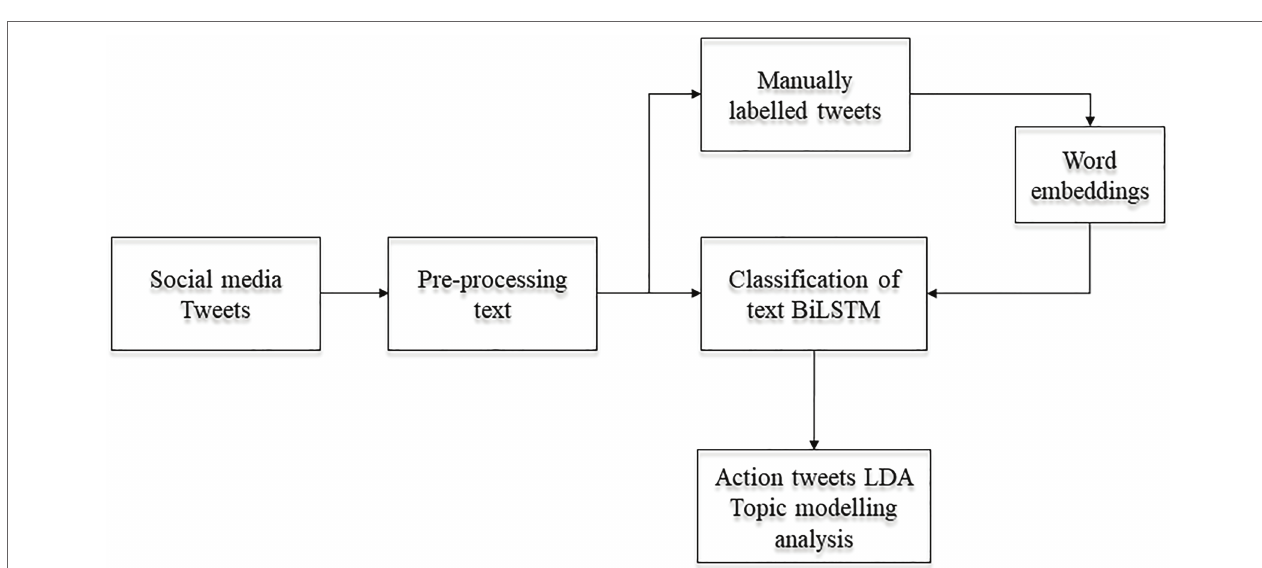
FIGURE 1 | Diagram of tweets processing and analysis. Tweets were streamed from social media on the three-timepoints, then pass through a pre-processing phase (removal of punctuation, mentions, etc.). A Bi-Directional Long Term Memory (BiLSTM) model was used for the clarification of tweets into action and non- action tweets. The inputs for the model were the word embeddings created from the manually labelled tweets. The action tweets detected from BiLSTM were then used for the analysis of the content with unsupervised technique LDA Topic